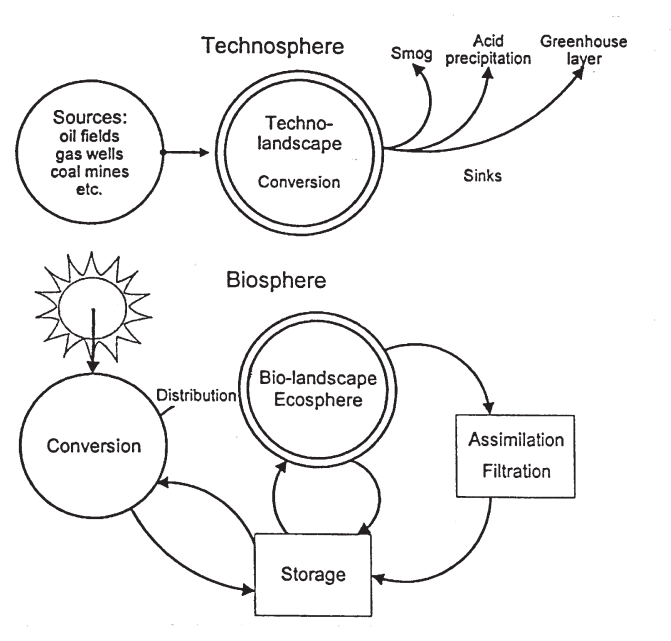
Figure 2: Biosphere landscapes as sustainable regenerative systems and technosphere landscapes as unsustainable throughput